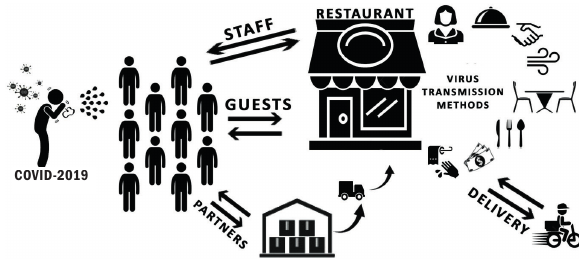
Figure 1 Transmission routes of 2019-nCoV at food service